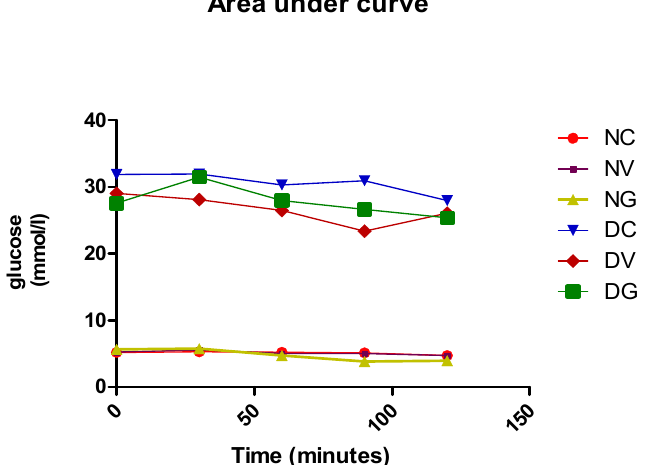
Figure 1. Graphical presentation of the e ff ect of vindoline in nondiabetic and diabetic rats on 2-h oral glucose tolerance test. Data represented as means ± SEM. NC: normal control; NV: normal control treated with vindoline; NG: normal control treated with glibenclamide; DC: diabetic control; DV: diabetic treated with vindoline; DG: diabetic treated with glibenclamide.